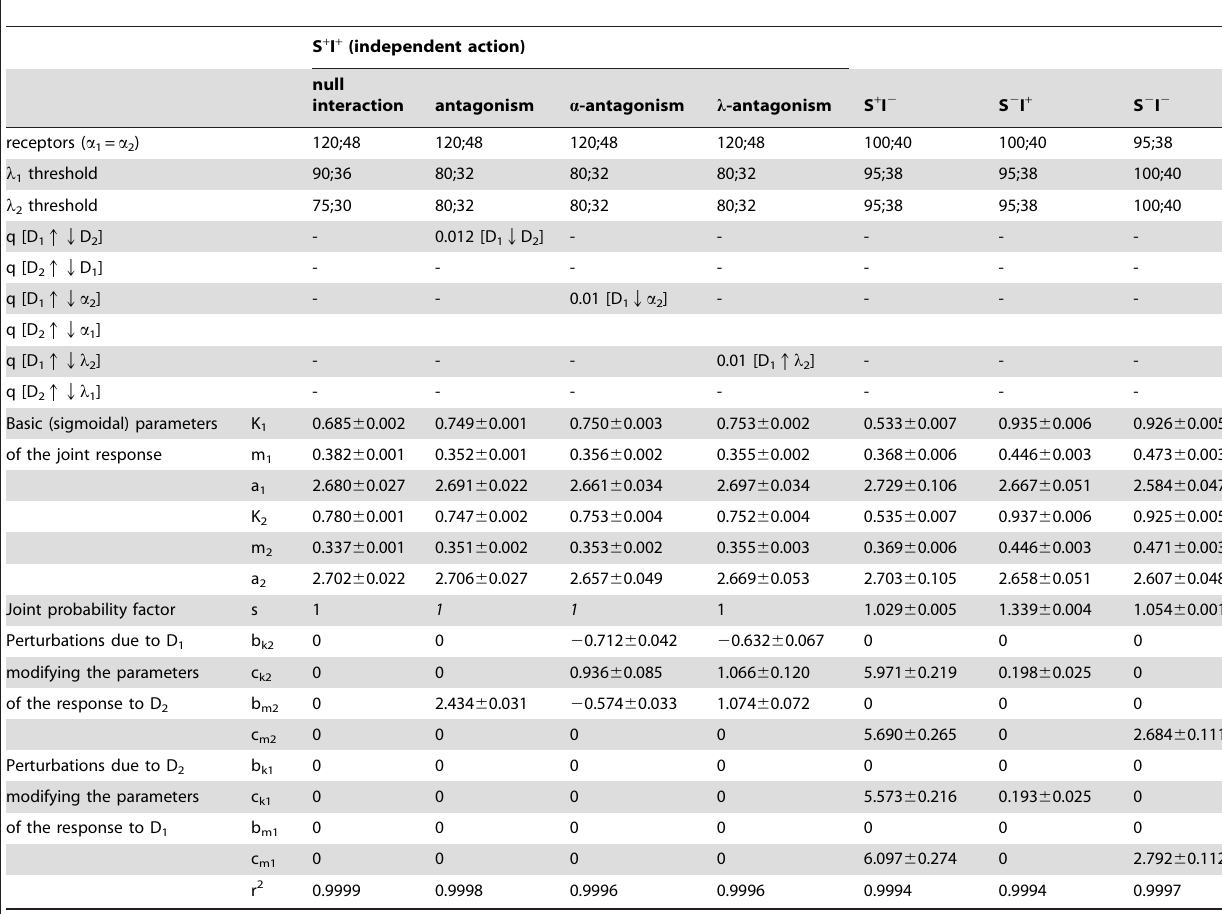
Table 4. Simulation conditions and respective fittings ( a =0.05) to the generalized IA model in the specified